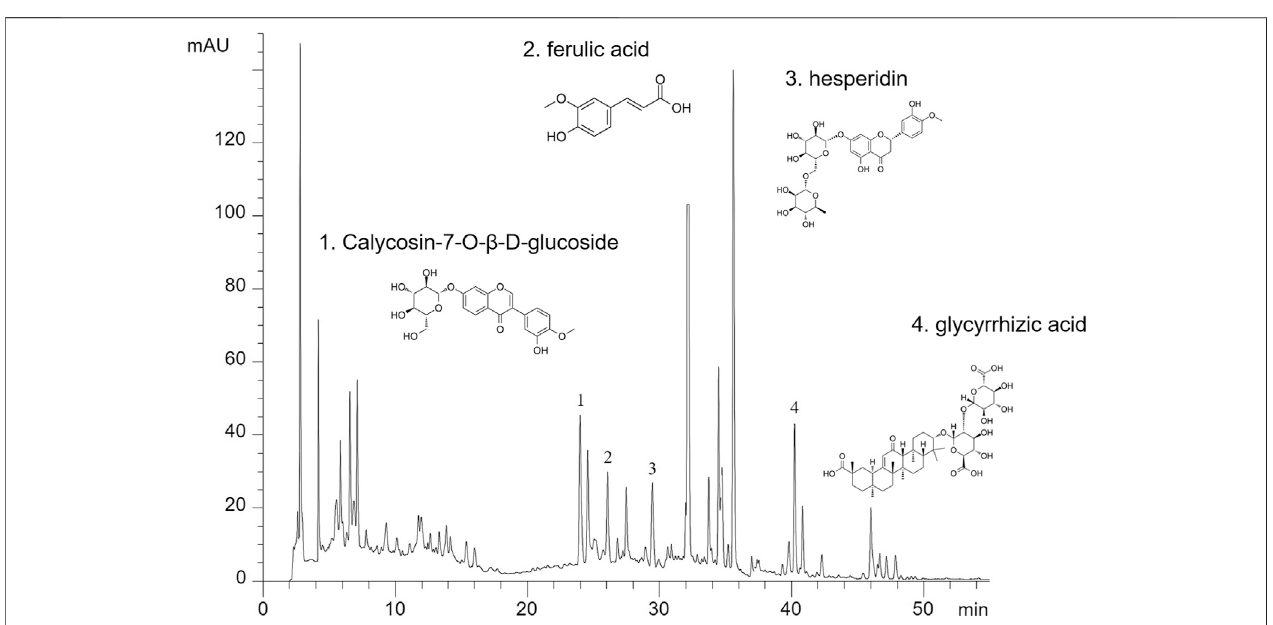
FIGURE1| EstablishmentofanewmodelofACLFinratsandtheexperimentalprocedures.Ratswererandomlydividedintothefollowingsevengroups(eightrats in each group).